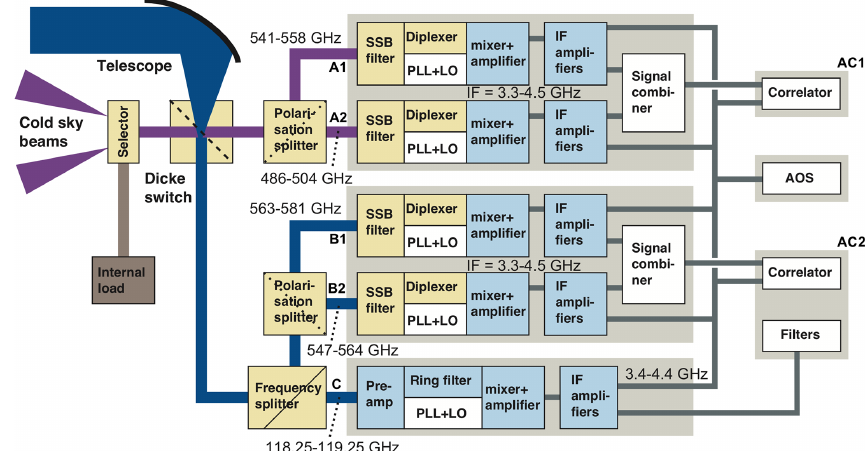
Figure 1. Block diagram of the Odin radiometer. From Frisk et al.